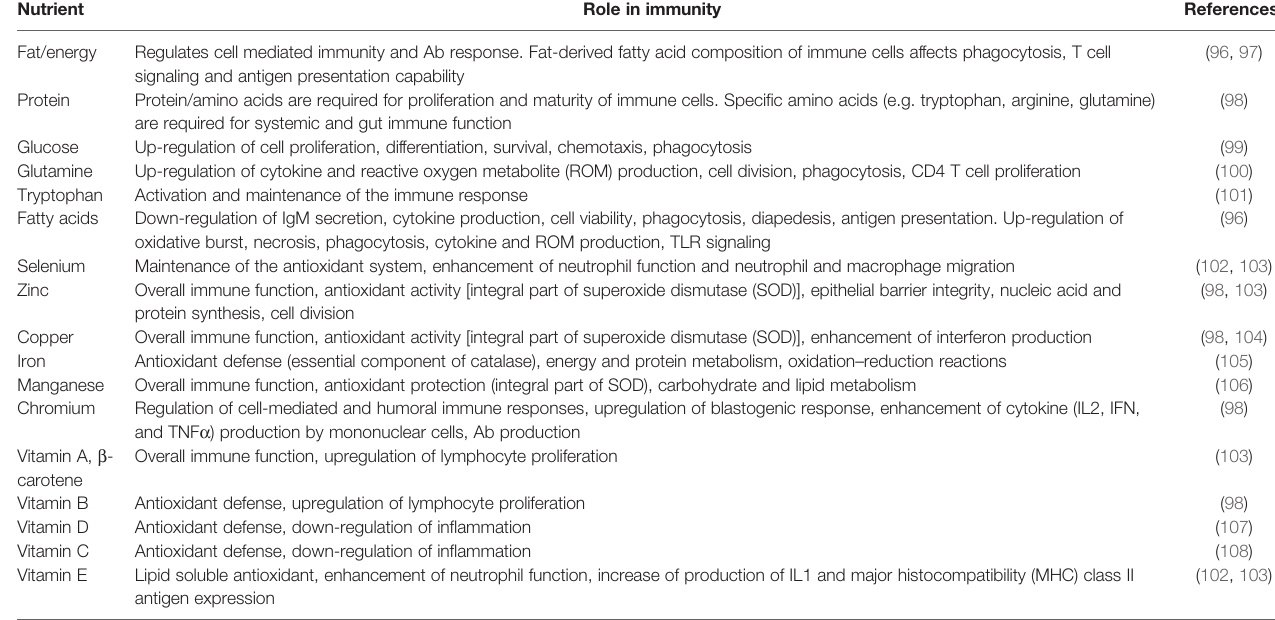
TABLE 1 | Role of macro- and micronutrients in the immune function of cattle. Nutrient Role in